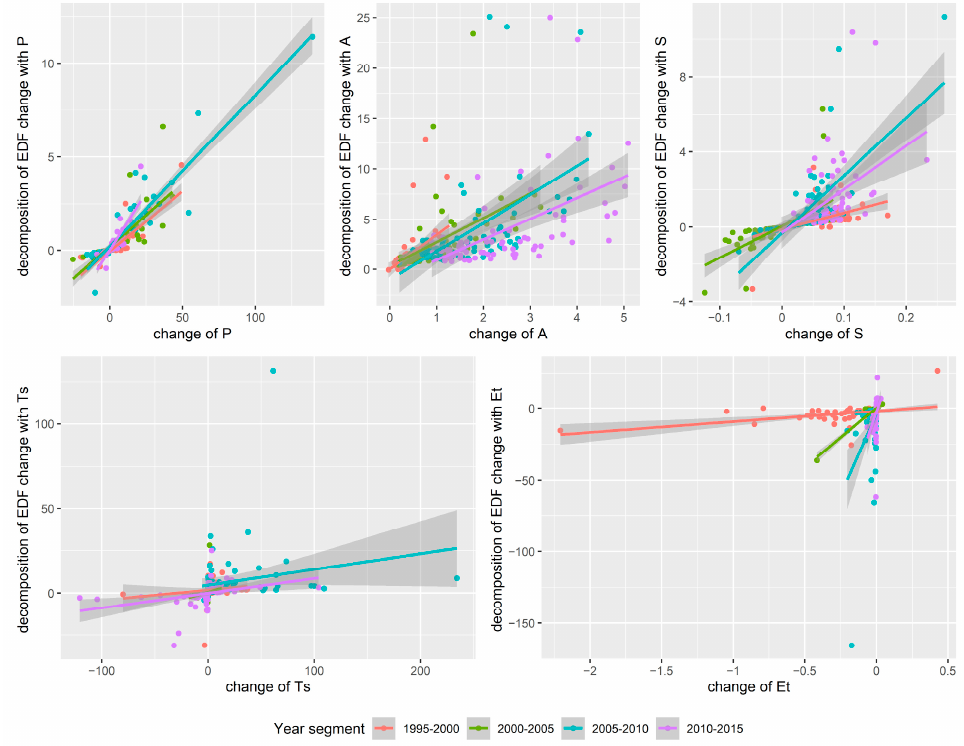
Figure 10. Relationship between the changes in factors and decomposition of EFD changes in Jiangsu in 1995–2015.